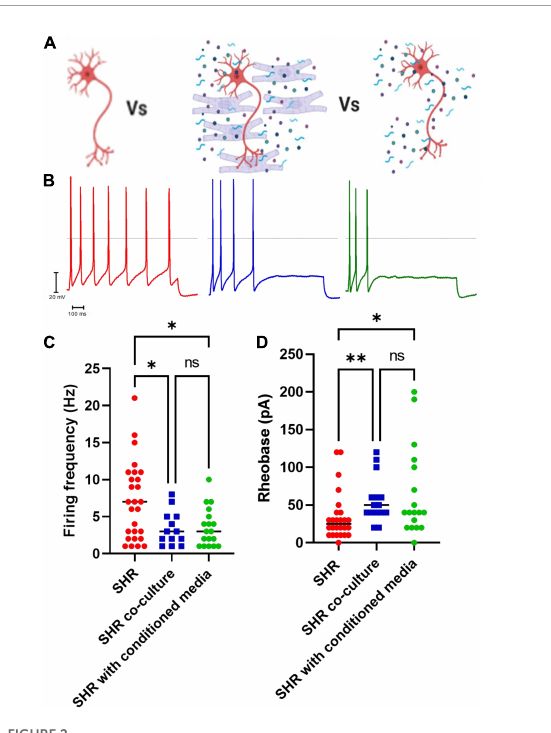
FIGURE2 Co-culture of SHR neurons with Wistar cardiomyocytes or Wistar cardiomyocyte conditioned media reduces SHR neuron excitability. Wistar and SHR neurons were co-cultured with Wistar cardiomyocytes or with Wistar cardiomyocyte conditioned media, and neuronal intrinsic electrical excitability was measured by whole-cell patch-clamp recordings of neuronal firing rate and rheobase. SHR neurons cultured alone exhibited a greater firing rate, and a lower rheobase, than SHR neurons co-cultured with Wistar cardiomyocytes. (A) Diagram demonstrating the experimental design. Here SHR neurons (Red) were cultured with Wistar cardiomyocytes (Blue), and thus able to physically and/or chemically interact with the cardiomyocytes. Alternatively they were cultured with Wistar cardiomyocyte conditioned media (Blue), which was expected to contain any factor released by cardiomyocytes. (B) Example traces of SHR neurons cultured alone (Red), with wistar cardiomyocytes (Blue) or with cardiomyocyte conditioned media (Green). (C) The maximum firing frequency of SHR neurons cultured with cardiomyocytes (Blue) when stimulated with 0–200 pA of current was lower than in SHR neurons cultured alone (Red) (Medians) (Kruskall–Wallis test; p = 0.0281; Dunn’s uncorrected comparison; n = 27, n = 13, p = 0.0345). A similar result was observed between SHR neurons cultured alone (Red) or with Wistar cardiomyocyte conditioned media (Green) (Uncorrected Dunn’s test; n = 27, n = 18, p = 0.0222). No signficant difference was observed between SHR neurons cultured with wistar cardiomyocytes (Blue) or wistar cardiomyocyte conditioned culture media (Green) (Uncorrected Dunn’s test; n = 13, n = 18, p = 0.9617). (D) The rheobase of SHR neurons cultured with cardiomyocytes (Blue) was higher than in SHR neurons cultured alone (Red), indicating a greater current was required to induce neuronal firing (Medians) (Kruskal–Wallis test; p = 0.0071) (Uncorrected Dunn’s test; n = 0.0041). This was also observed for SHR neurons cultured alone (Red) or co-cultured with Wistar cardiomyocyte conditioned media (Green) (Uncorrected Dunn’s test; n = 0.0291). No difference was observed between SHR neurons co-cultured with Wistar cardiomyocytes (Blue) or Wistar cardiomycoyte conditioned media (Green) (Uncorrected Dunn’s test; n = 0.5130).